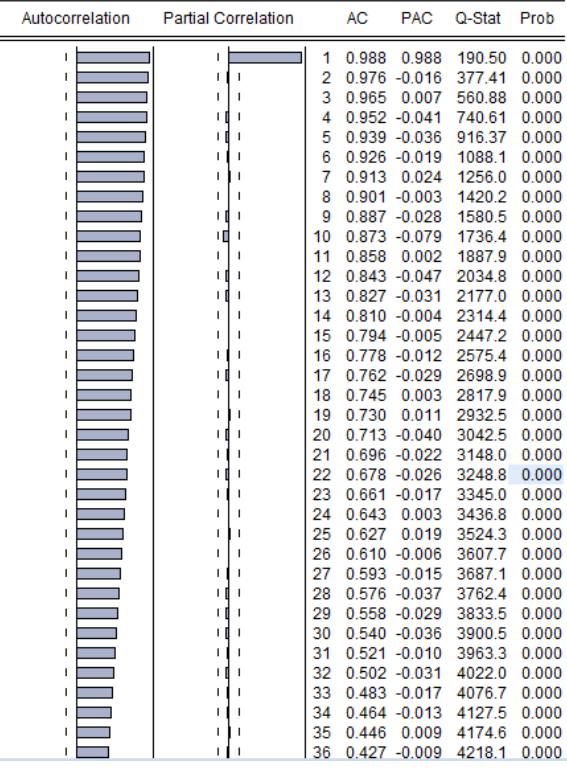
Figure 5. The State Debt of Ukraine 2004–2020 сorrelogram, USD ths.